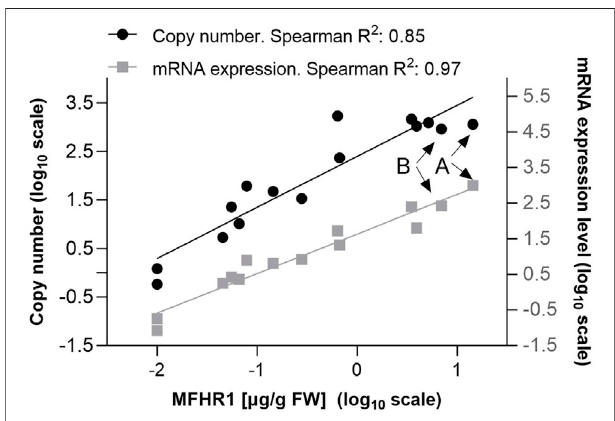
FIGURE 1 | Positive correlation between three molecular levels: number of integrations of expression cassettes, mRNA expression level and recombinant protein production. The correlation was estimated with 14 – 15 MFHR1 producer lines, which include low and high producers. The experimentwasperformed1 yearaftermosstransfection.Linearregressionin logarithmic scale is shown. Lines A and B selected for the next experiments are marked with arrows. mRNA expression levels were determined by qRT- PCR. Samples were normalized using two reference genes (coding for EF1- α and 60S ribosomal protein L21) and the line with the lowest expression level was used as calibrator. Number of integrations of expression cassettes was determined by qPCR. Samples were normalized with the single copy gene PpCLF